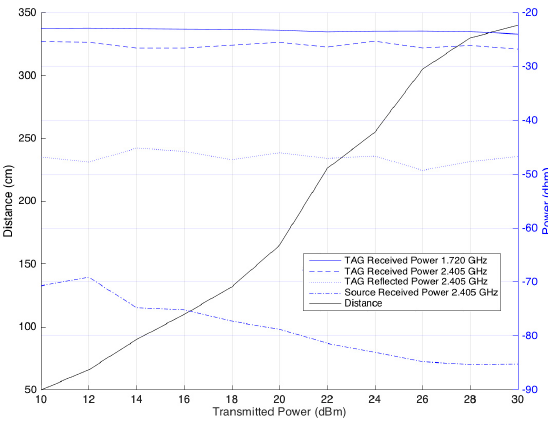
Figure 11. Transmitted power vs. maximum distance.